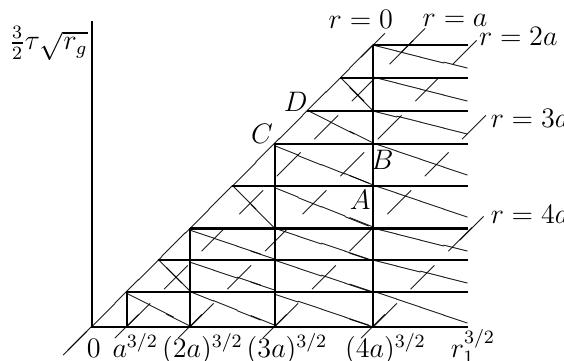
Figure 1. A typical triangulation with the simplest periodic lattice in the Lemaitre coordinates, drawn in a section passing through the world line r = 0 (however, for another such section, there are events of ending geodesics r 1 = const at r = 0, say, r 1 = a √ 2, which do not belong to any of these leaves τ = const ; therefore, the structure should be distorted near r = 0, for example, a line r 1 = const before r = 0 can end with a non-( r 1 = const ) edge). BC , AB and AC are examples of the spatial, temporal, and diagonal edges, respectively. CD is an edge at r =